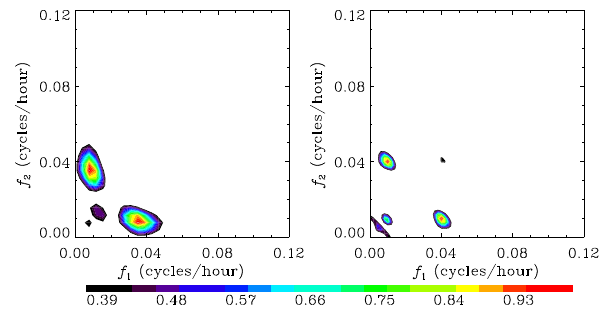
Figure 9. Bispectra for (left) zonal and (right) meridional winds at 5.51km in April 2012.